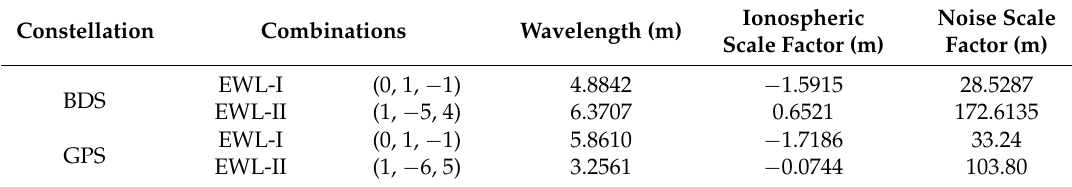
Table 1. Characteristics of the selected phase combinations.